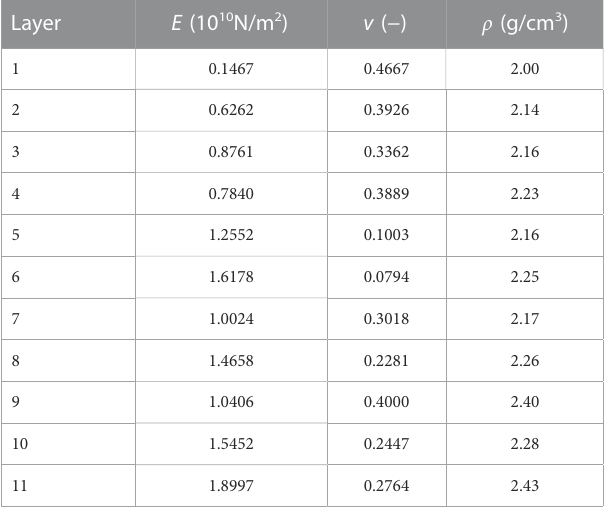
stable inversion results. The multilayer geologic model is smoothed by a moving average fi lter to generate the low- frequency initial models. Figure 6 shows the true (black lines) and initial (gray lines) values and the direct inversion results (Figure 6A red, blue, and green lines respectively) and the indirect calculated results (Figure 6B red, blue and green lines respectively) of Young ’ s modulus, Poisson ’ s ratio and density without noise. The exact forward modeling and robust and effective inversion method and input data without noise ensure that the direct inversion results agree well with the true models than the indirect calculated results. Correlation analysis for the direct inversion and indirect calculation (Figure 7) quanti fi es these improvements: the correlation coef fi cients (CC) of Young ’ s modulus, Poisson ’ s ratio, and density for direct inversion are 0.9998, 0.9997, and 0.9985, respectively; while the coef fi cients for indirect calculation are 0.9906, 0.9894, and 0.9817, respectively. Meanwhile, we calculated the mean-relative error (mr error) of direct inversion results and indirect calculated results, as shown in Table 3. Correlation density (green) obtained by the direct estimation method (solid line) and the indirect calculation method (dashed line) as the number of calculation iterations increases, it was found that after 3 iterations, the directly estimated Young ’ s modulus and the Poisson ’ s ratio correlation coef fi cients had reached a high value and tended to be fl at, and the density term also tended to be high and fl at after 5 iterations, while the indirectly calculated Young ’ s modulus and Poisson ’ s ratio correlation coef fi cient had not reached a relatively high value after 7 iterations, and the correlation coef fi cient of the density term begins to gradually decrease after 4 iterations, which